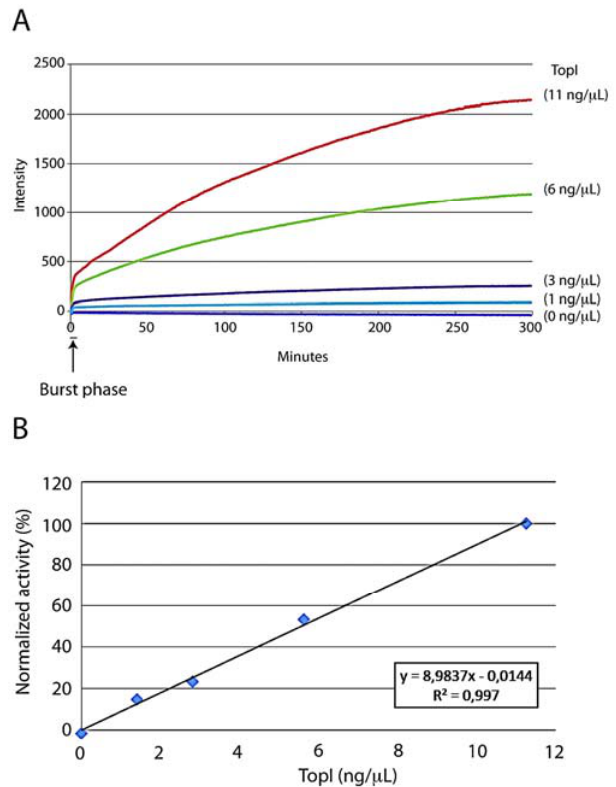
Figure 2. ( A ) A graphic depiction of the fluorescence emission measured as a function of time upon incubation of the DNA sensor with different concentrations of purified hTopI (indicated to the right of the figure) ( B ) Graphical representation of the results depicting the mean initial velocity of three individual reactions similar to the example shown in (A) plotted as a function of enzyme concentration. Data were normalized against the initial velocity of the highest enzyme concentration (corresponding to 100%) obtained in each